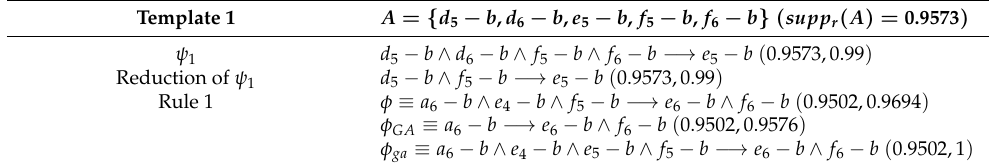
Table A10. Templates, association rules and generalized association rules in the connect-4 database.